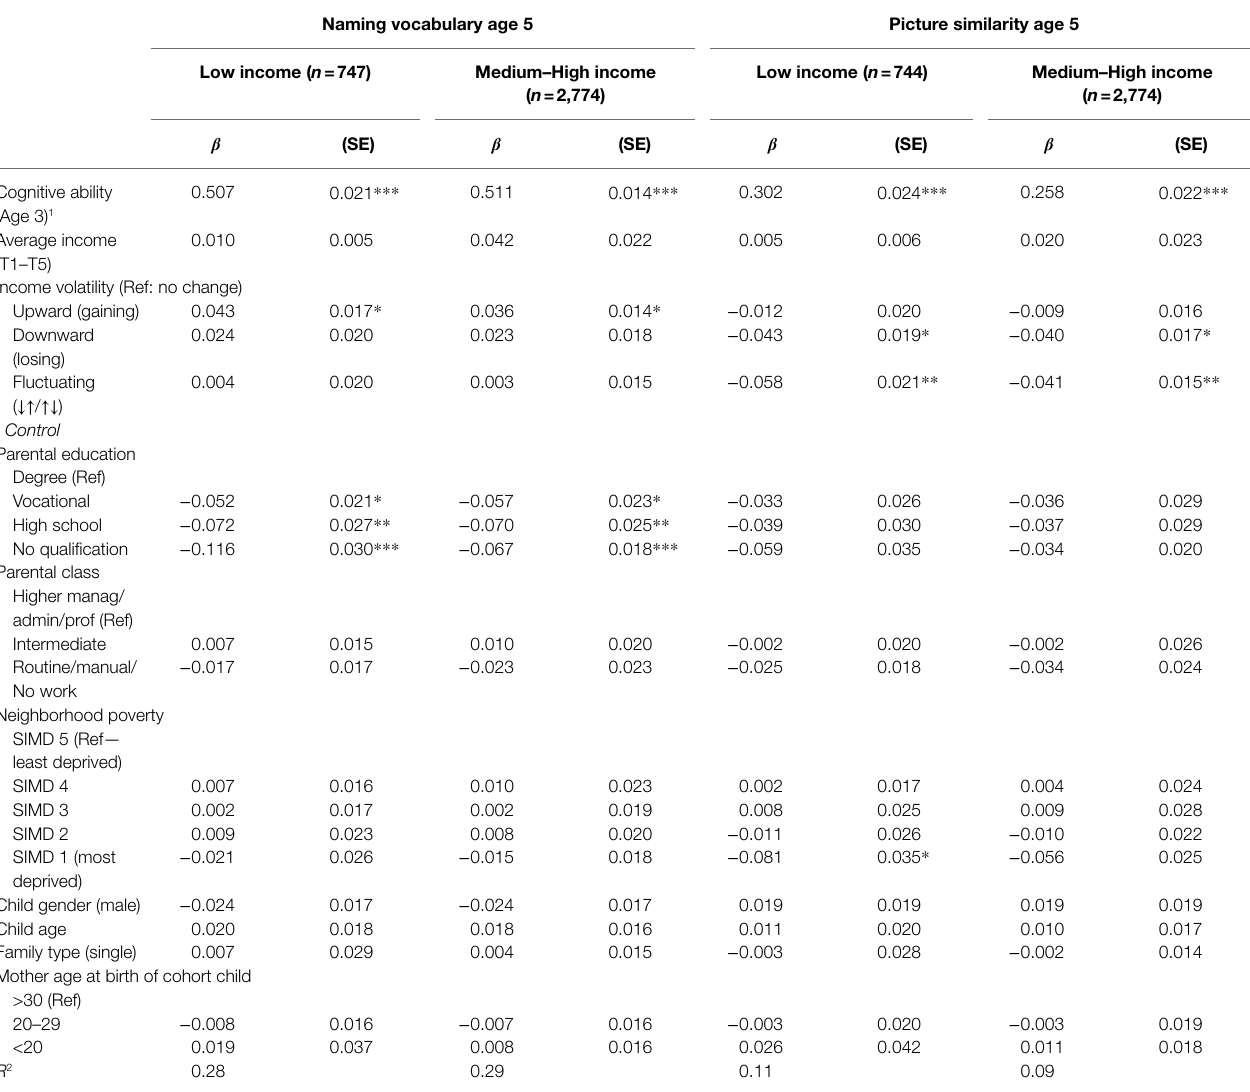
TABLE 4 | The standardized coefficients of income dynamics (average income and volatility) on change in cognitive ability from ages 3 to 5 for low and medium–high- income